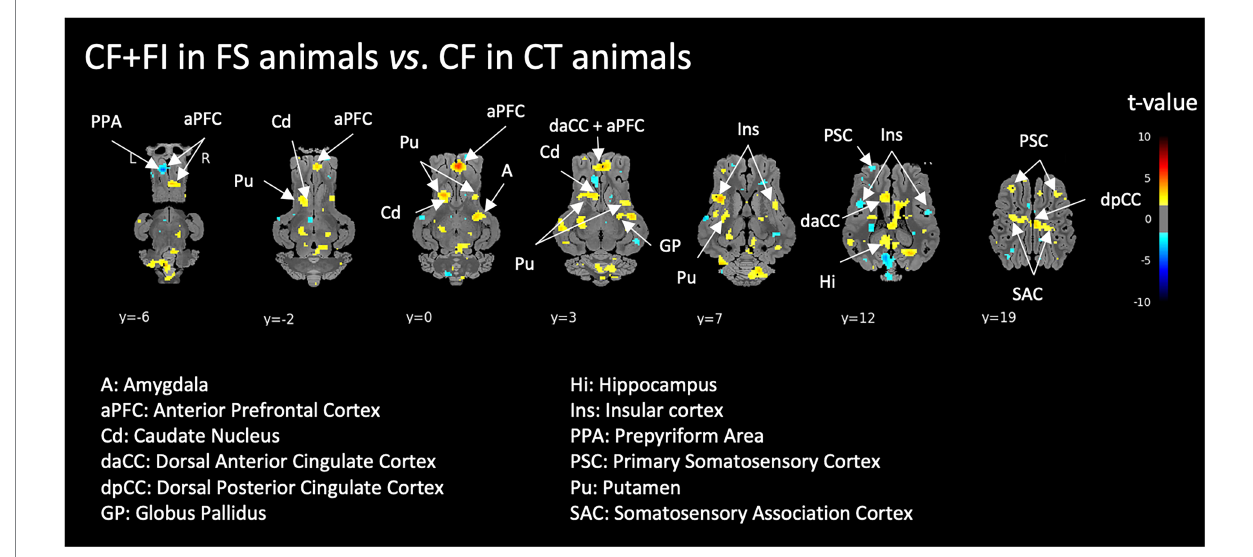
FIGURE 3 Brain responses to the control feed odor ( CF ) supplemented with the functional ingredient (FI) in FI-habituated animals (FS) compared to the brain responses to the control feed odor ( CF ) in control animals (CT). Horizontal maps of brain BOLD responses are represented at different dorsal-ventral levels ( y ) related to the posterior commissure (in mm). Value of p threshold = 0.05, k > 20 (number of voxels per cluster).